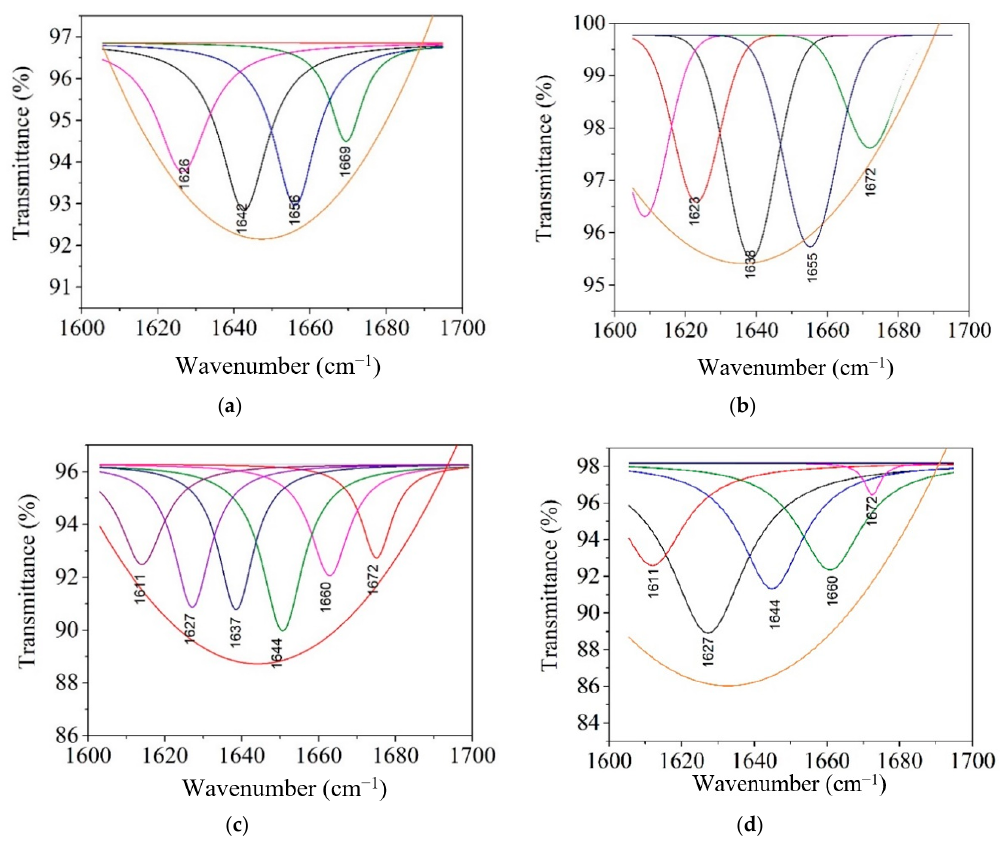
Figure 5. Deconvolution spectra for the electrospun collagen glue loaded with antimicrobial agents: Col—collagen glue nanofibers ( a ), Col / ZnO NPs ( b ), Col / TiO 2 -N-Ag NPs ( c ), and Col / CS ( d ).